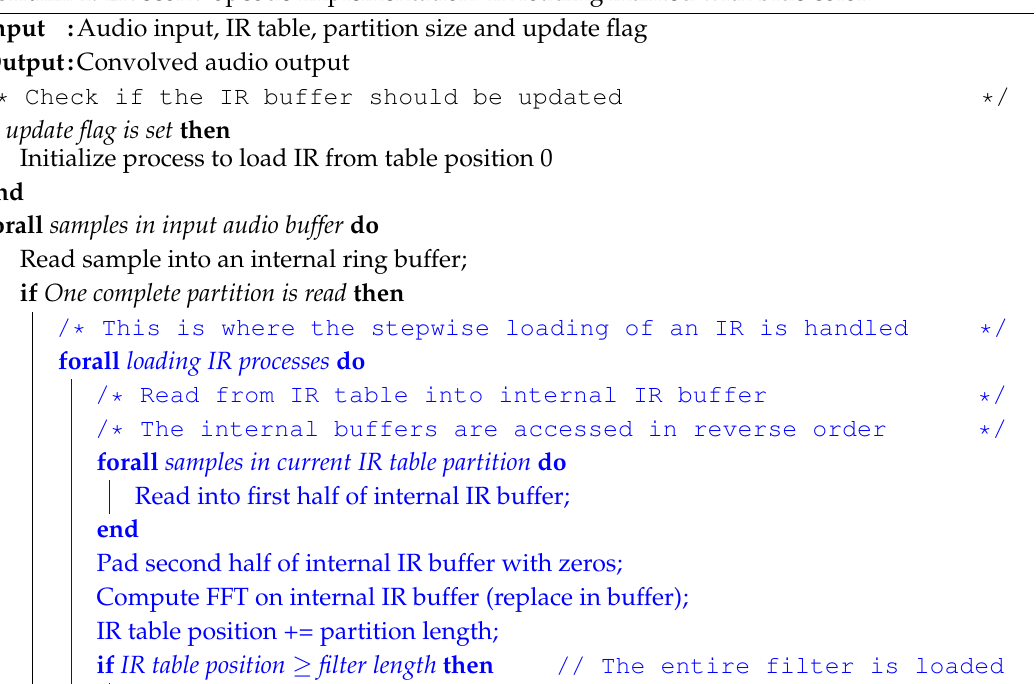
Algorithm 1: Liveconv opcode implementation. IR loading marked with blue